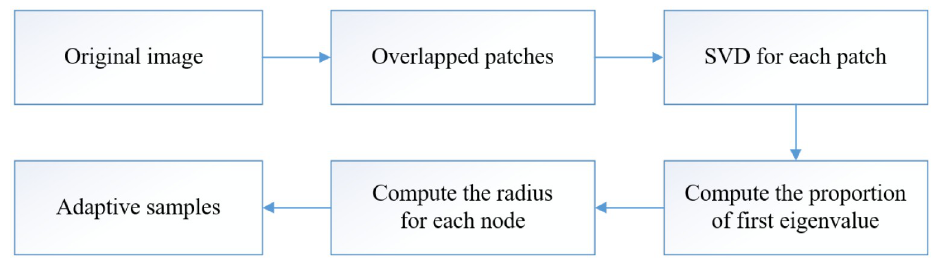
Fig 1. The flowchart of SVD based maximal Poisson-disk sampling for DEM simplification.